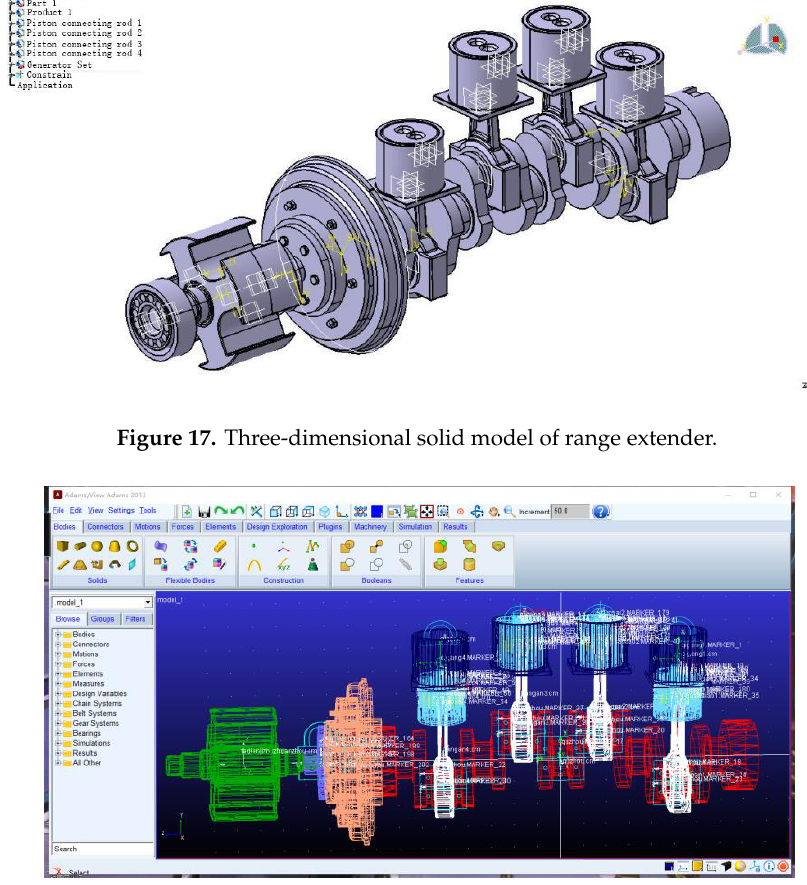
Figure 18. Rigid flexible coupling multi-body dynamic model of range extender. Processes 2020 , 8 , x FOR PEER REVIEW